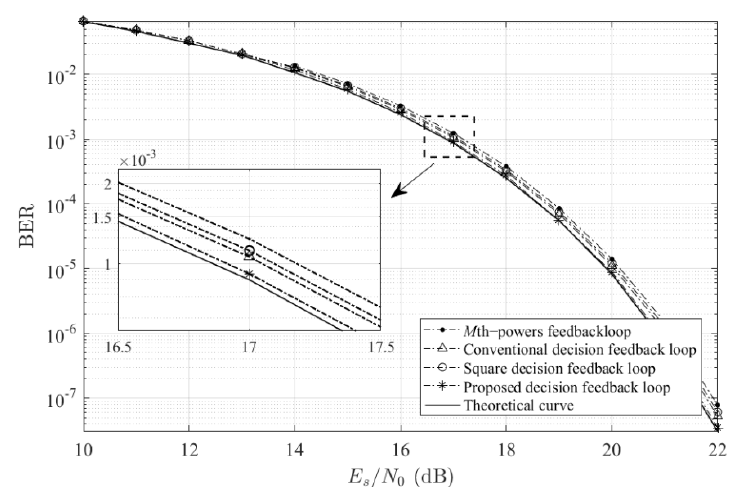
Figure 6. BER versus T coh for different feedback loops.